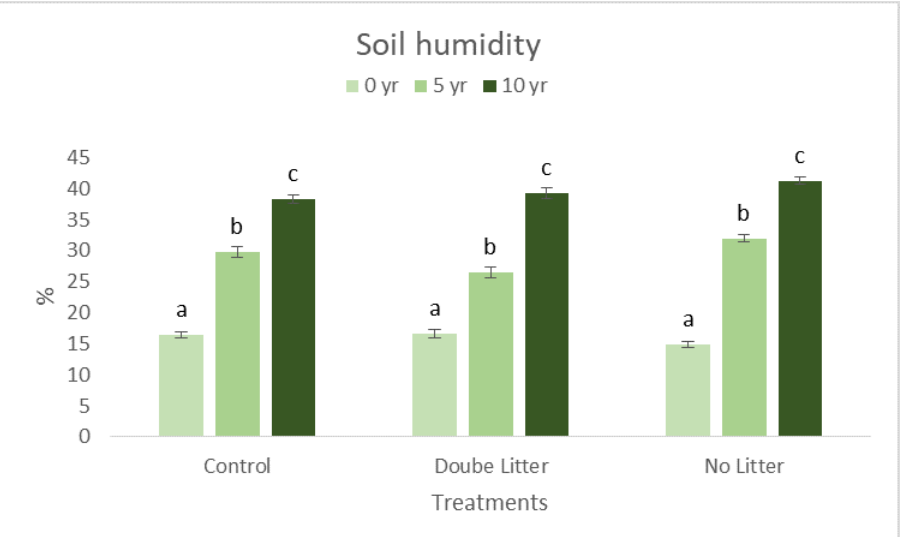
Figure 3. Soil moisture at the start of the treatments and after 5 and 10 years, based on spring measurements (Average of 6 samples per treatment; Letters indicate the significant difference between treatments within the same sampling time.).